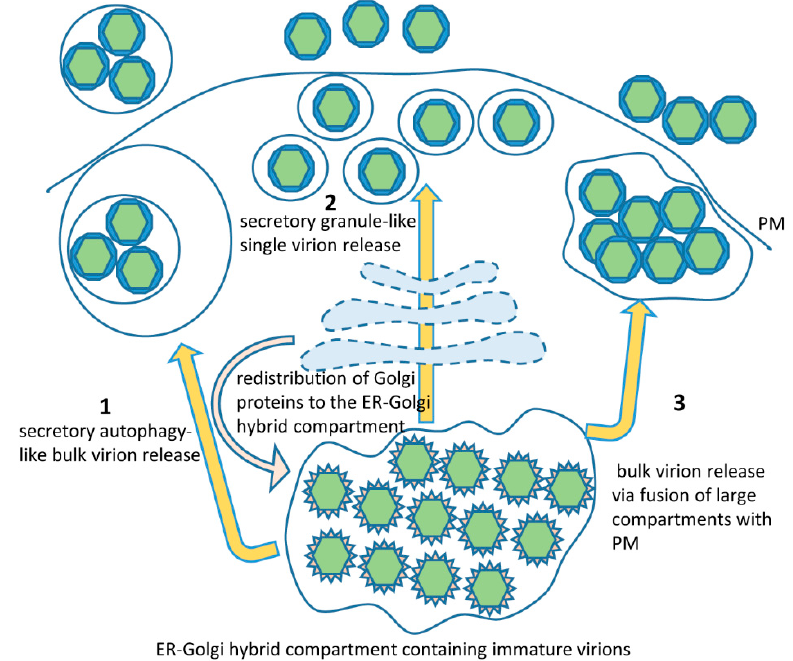
Figure 3. Possible Zika virion secretion pathways. Immature virions accumulate in the ER-Golgi hybrid compartment where the viral surface glycoproteins undergo final glycosylation and proteolytic maturation. Membrane-wrapped clusters of virions could be secreted through a secretory autophagy-related pathway (pathway 1). Individual virions can be released via a secretory granule-like mechanism after repackaging into individual small membranous carriers (pathway 2), which seems to be the major mechanism of virion egress. Virion clusters could be released via direct fusion of the large membranous compartments with the PM (pathway 3).